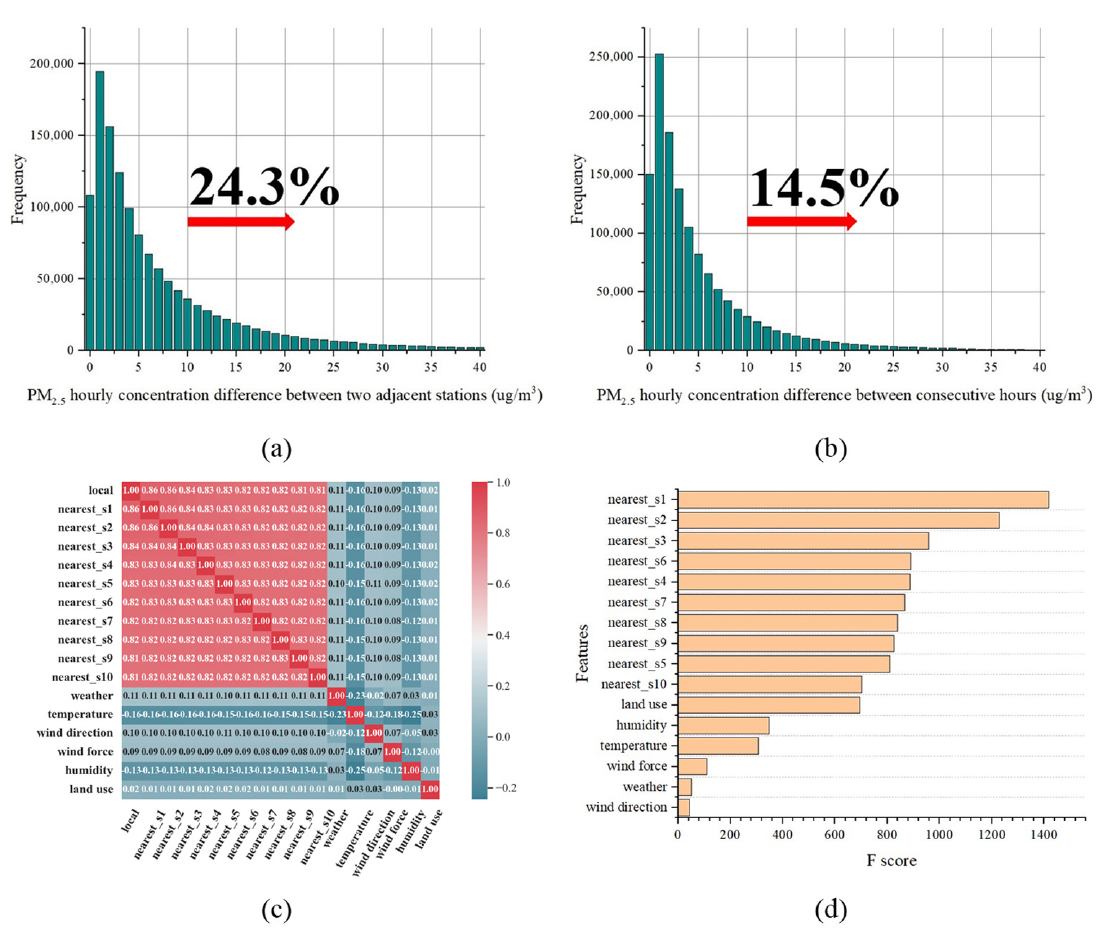
Figure 3. ( a ) PM 2.5 hourly concentration differences between two adjacent stations at the same hour; ( b ) PM 2.5 hourly concentration differences for the same stations between two consecutive hours; ( c ) Spearman correlation between PM 2.5 pollution and the predictors; ( d ) feature importance of different predictors for PM 2.5 pollution inference.